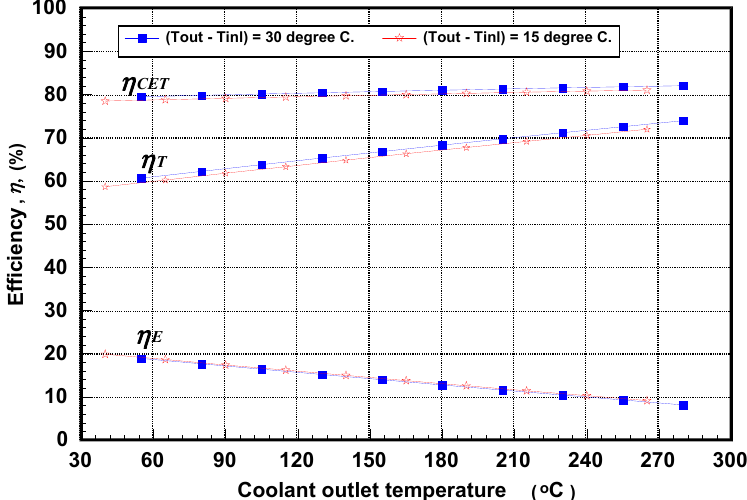
Figure 23. The variation of the CPVT collector electric, thermal and CTE efficiencies with the cooling outlet water temperature (constant ṁ = 0.01 kg/sec and fixed ∆ T coolant = 15 °C and 30 °C).